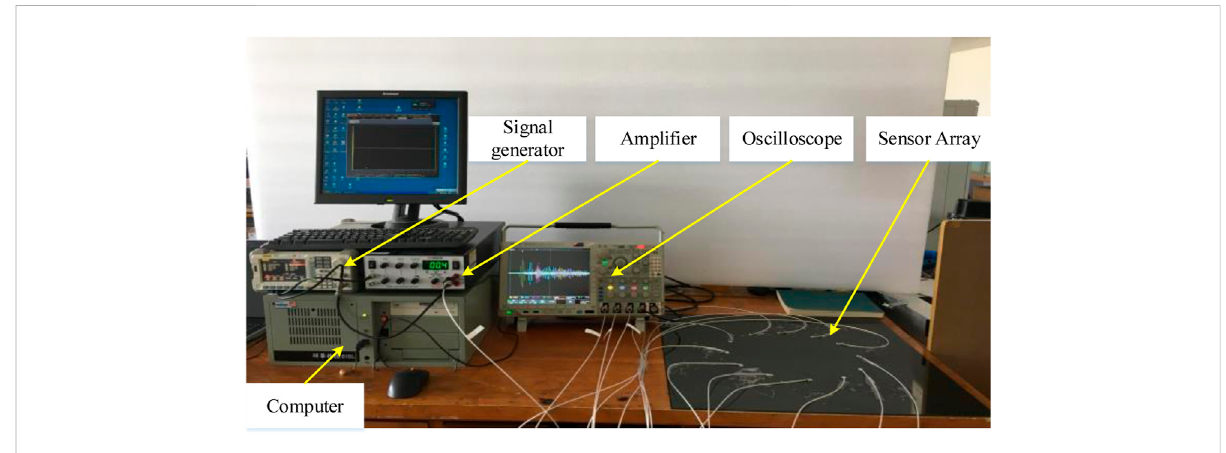
FIGURE 11 Photograph of Lamb Wave Tomography experimental